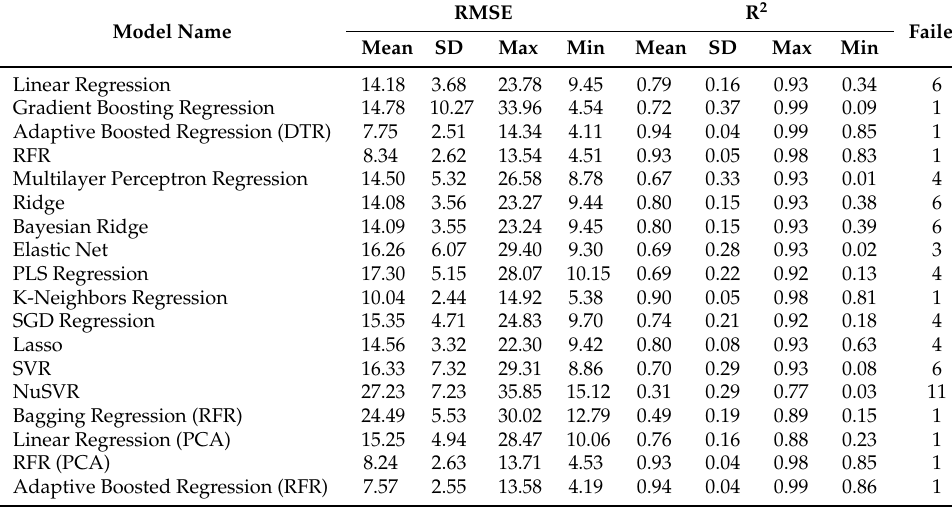
Table A1. RMSE and R 2 values for all models tested on flexion\slash extension. The failed column shows the number of subjects predicted with negative R 2 values from each model. All models were optimized using Bayesian or grid search optimization. Data presented in this work were calculated with the adaptive boosted regression (RFR) model.